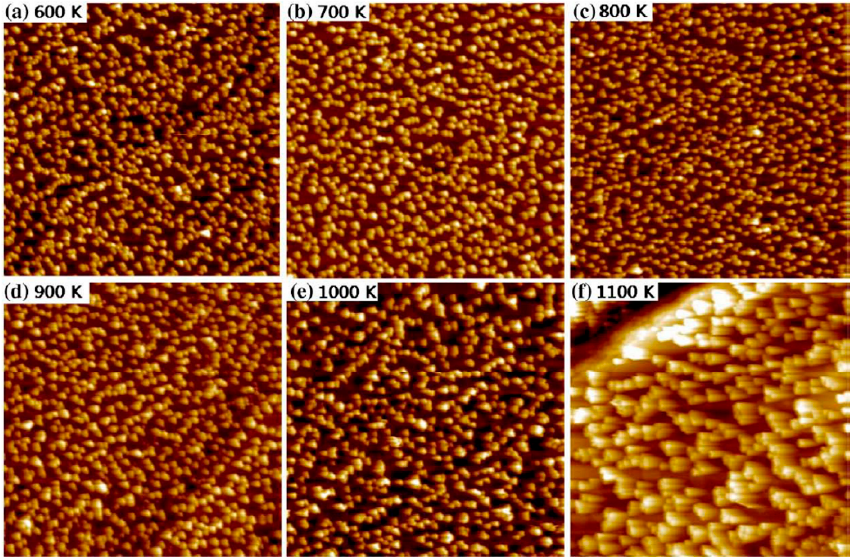
Figure 11. Scanning Tunneling Microscopy images (50 nm × 50 nm) of 0.8 ML Rh on graphene/Ru(0001) acquired after annealing the samples to ( a ) 600 K; ( b ) 700 K; ( c ) 800 K; ( d ) 900 K; ( e ) 1000 K and ( f ) 1100 K for 10 minutes. Reproduced from Reference [65] with permission from the Elsevier.